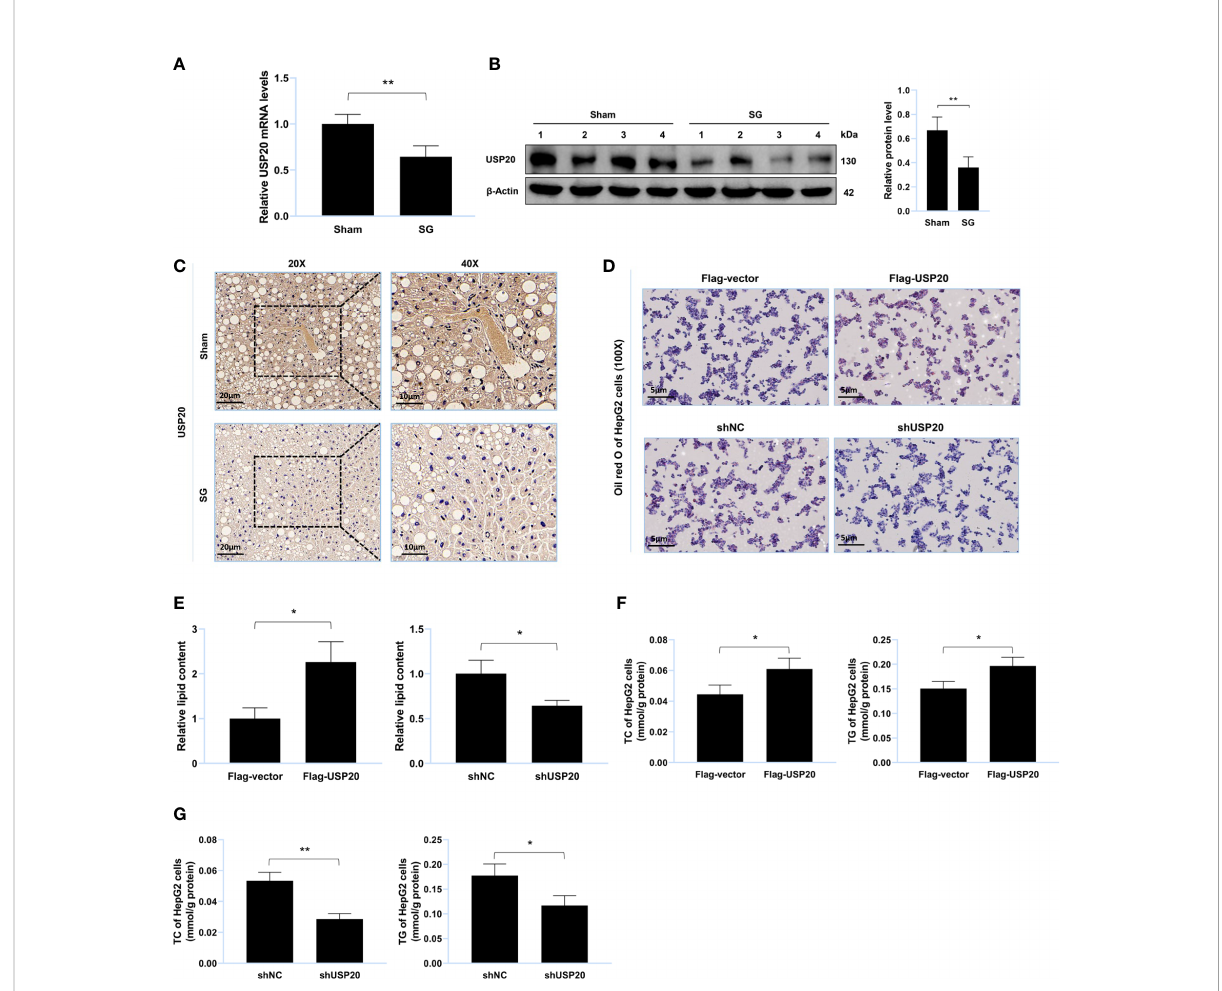
FIGURE 2 USP20 promotes lipid accumulation in vitro . (A) Relative mRNA level of USP20 in liver from sham group and SG group (n = 4). (B) Western blot detection of USP20 in liver from sham group and SG group (n = 4). (C) Immunohistochemistry detection of USP20 in liver from sham group and SG group. Scale bars were shown in the fi gure. (D) HepG2 cells were transfected with Flag-USP20, Flag-vector, shUSP20 and shNC. Lipid accumulation of HepG2 cells was assessed by Oil Red O staining. Scale bars were shown in the fi gure. (E) Relative lipid content of HepG2 cells (n = 3). (F, G) TC and TG content of HepG2 cells (n = 3). The data are expressed as mean ± SEM, Student ’ s t-test was used for intergroup comparisons. *p < 0.05, **p <